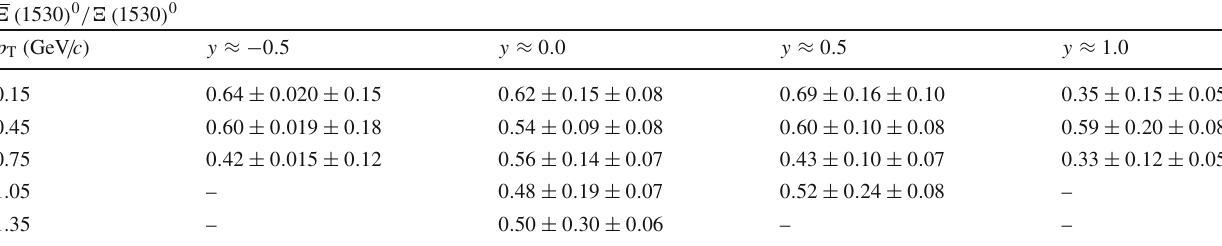
Table 5 The (cid:2)( 1530 ) 0 /(cid:2)( 1530 ) 0 ratio in inelastic p+p interactions at 158 GeV / c beam momentum. Rapidity and transverse momentum values correspond to the middle of the presented bin. The first value is (cid:2)( 1530 ) 0 /(cid:2)( 1530 ) 0